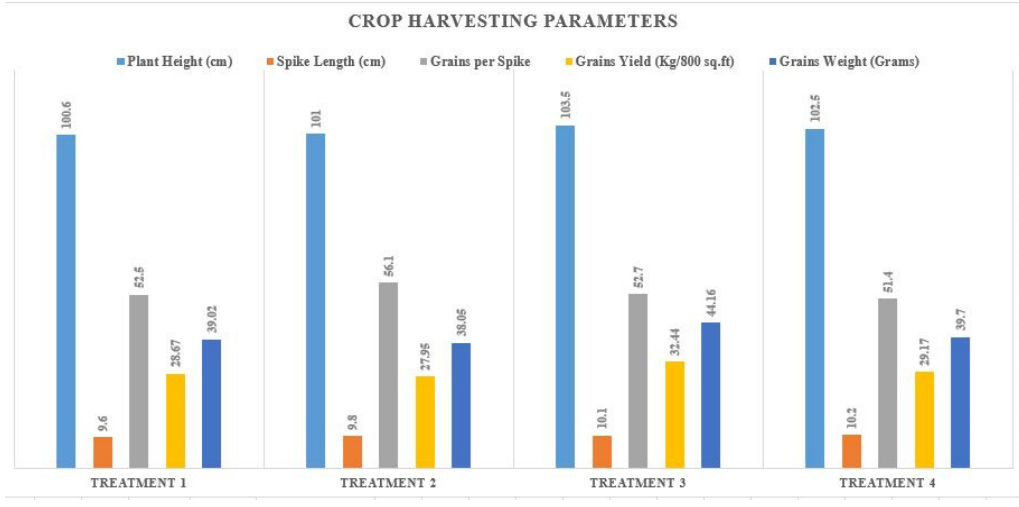
Figure 2. Graphical representation of the harvesting parameters . Histogram and Normal Probability Plot of Crop Harvesting Parameters